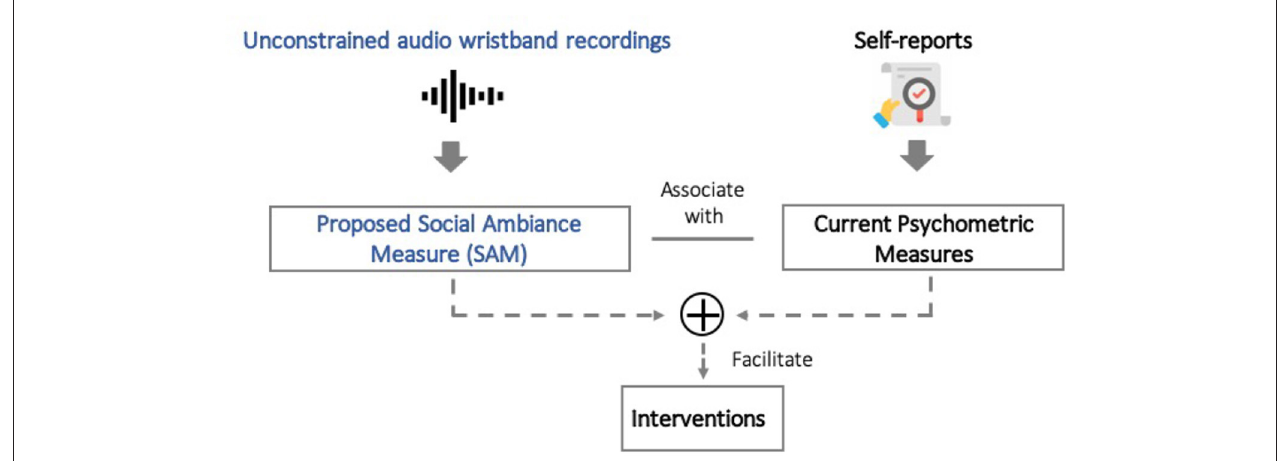
FIGURE 1 | In this paper, we study if social ambiance measure (SAM) associate with psychometrics measures. The new findings could empower new in-time interventions for improving mental health